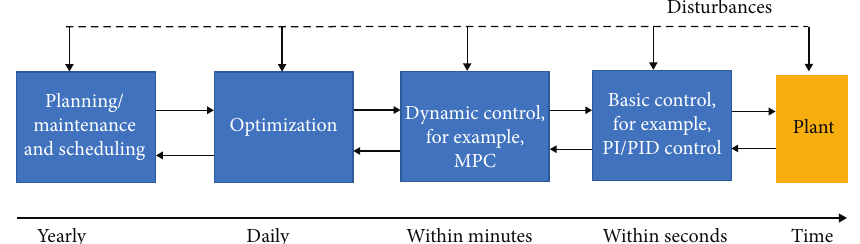
Figure 8: A control hierarchy with respect to a timeline. This diagram illustrates when and where MPC which is a dynamic control is placed in a control hierarchy.